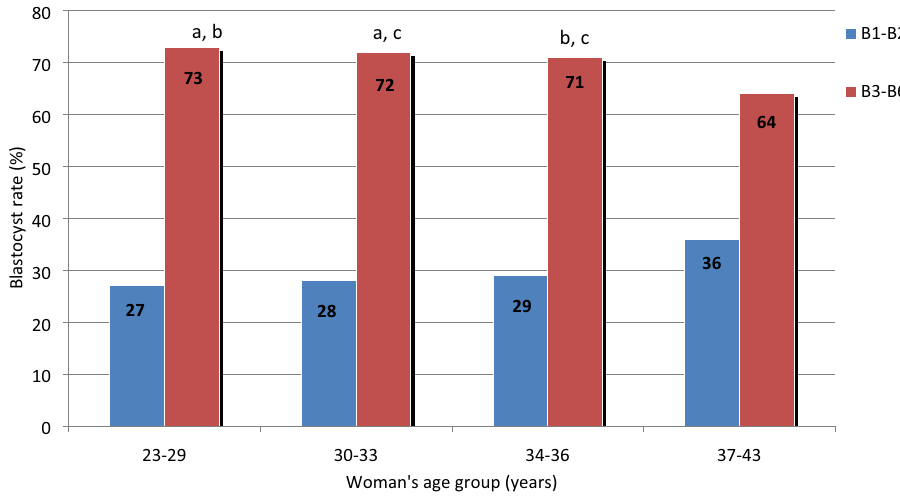
Figure 2. Stage of blastocyst expansion obtained at D5 as a function of the woman’s age group. The blastocyst rate is the ratio between the number of blastocysts obtained at D5 or D6 and the number of normally fertilized zygotes at D1. B1: early blastocyst (the blastocoel being less than half the volume of the embryo). B2: early blastocyst (the blastocoel being greater than half the volume of the embryo). B3: full blastocyst (the blastocoel completely filling the embryo). B4: expanded blastocyst (the blastocoel volume now being larger than that of the early embryo and the zona starting to thin). B5: hatching blastocyst (the trophectoderm starting to herniate though the zona). B6: hatched blastocyst (the blastocyst having completely escaped from the zona) (from Gardner, D. K. & Schoolcraft, W. B, 1999) 25 . Columns with the same superscript letters are not significantly different ( P >